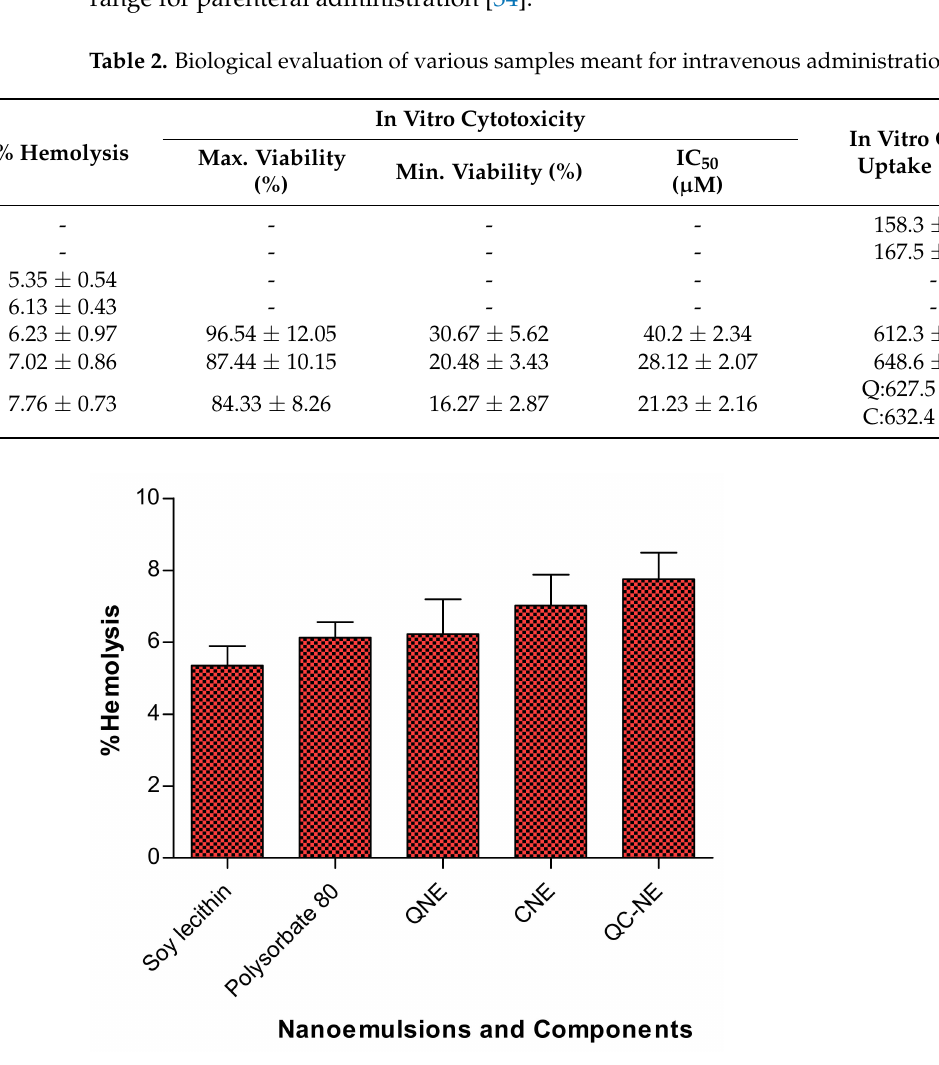
Figure 3. Hemolysis (%) of soy lecithin, polysorbate 80, QNE, CNE and QC-NE. p >